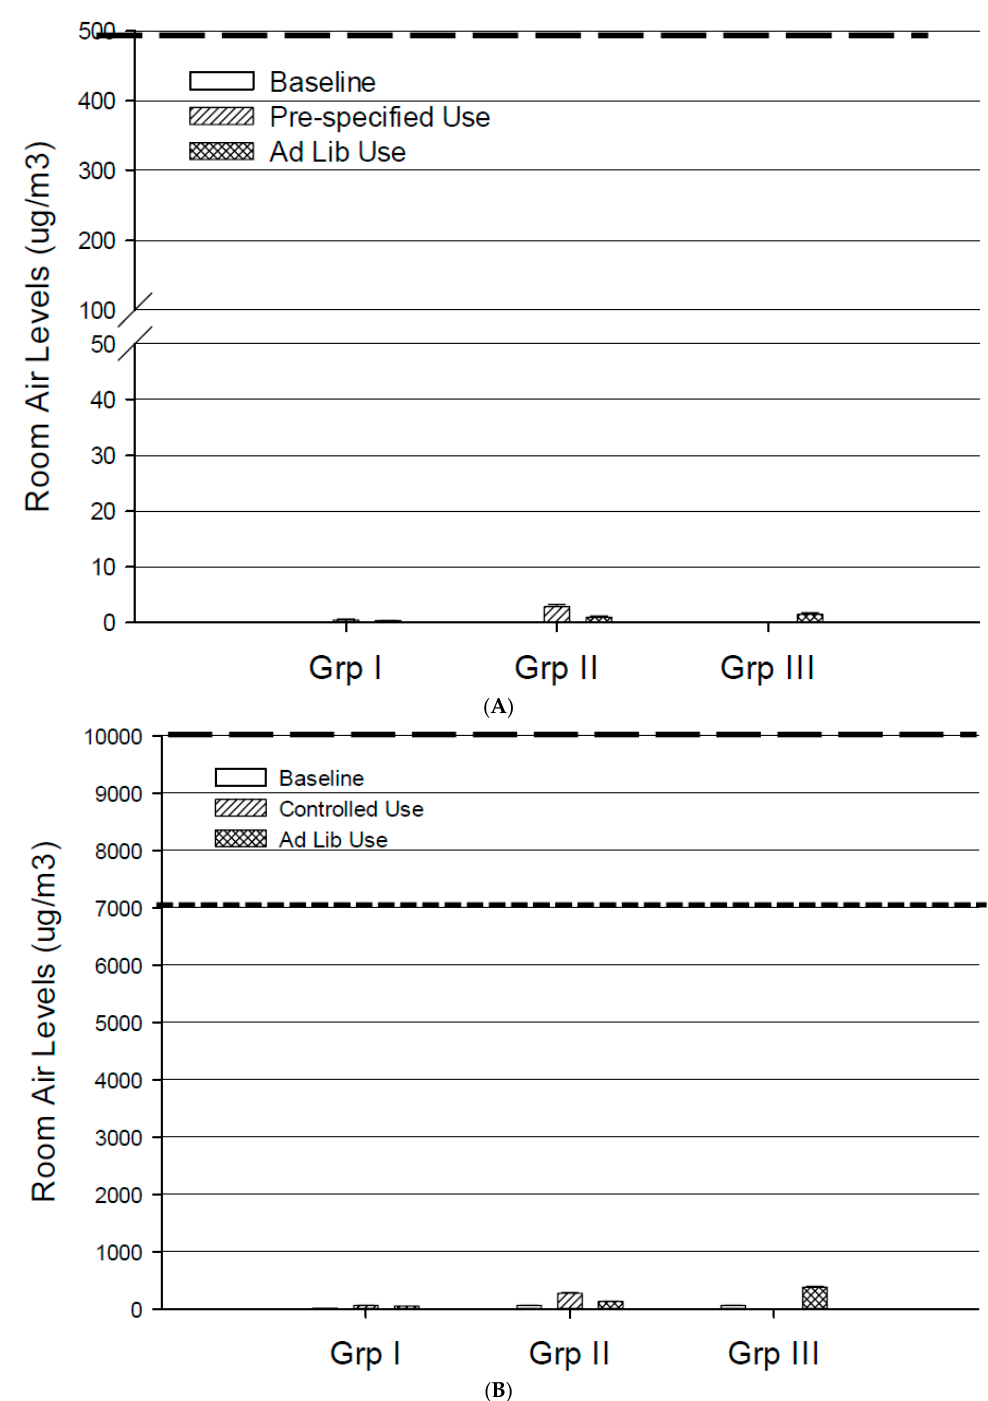
Figure 3 . Cont . Figure 3. Cont